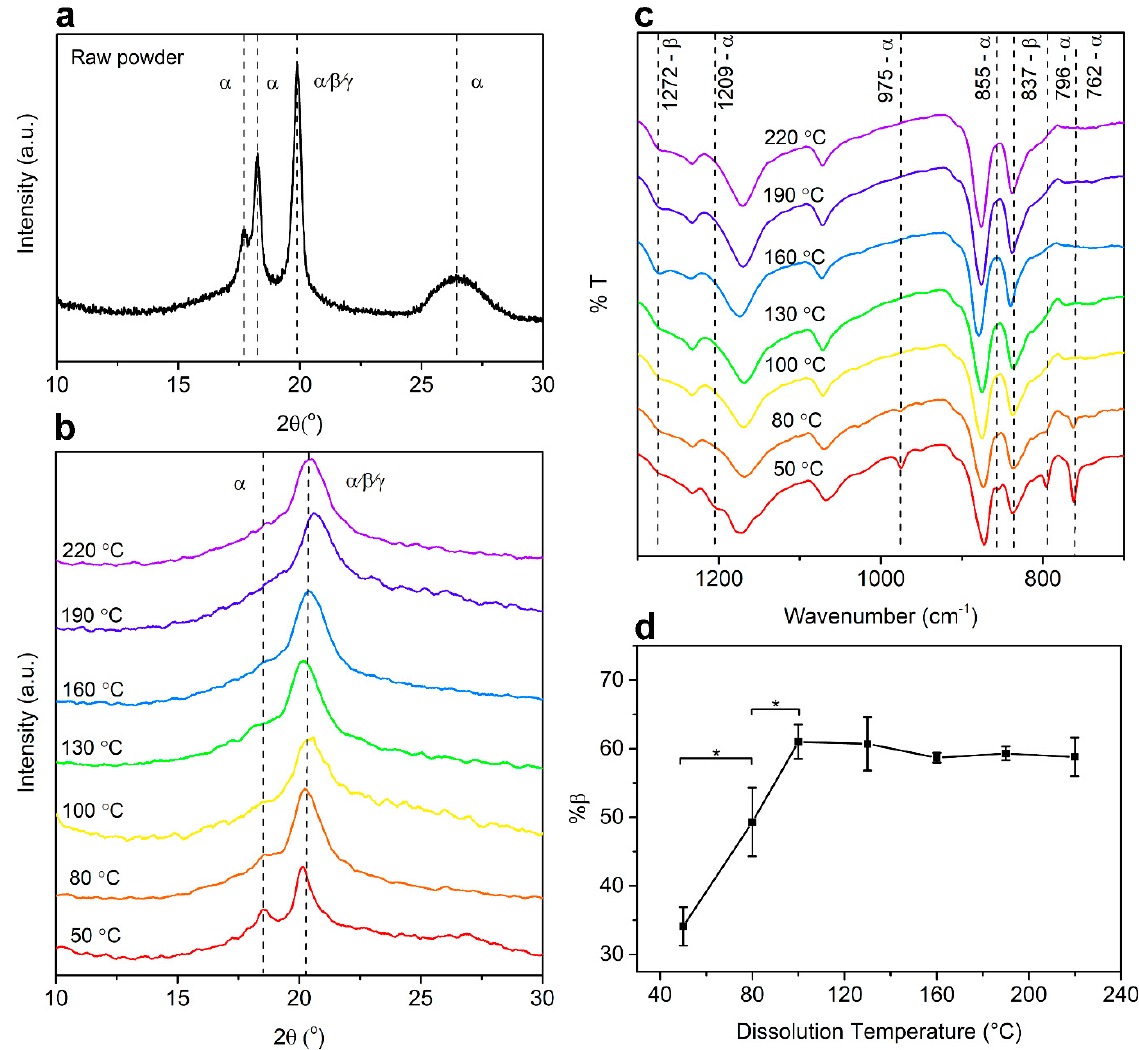
Figure 1. Phase characterization of polyvinylidene fluoride (PVDF). ( a ) X-ray diffraction (XRD) spectra indicating the characteristic peaks of α -PVDF and β -PVDF for raw PVDF powder. ( b ) XRD spectra and ( c ) Fourier-transform infrared spectroscopy (FTIR) spectra of PVDF films fabricated at dissolution temperatures of 50 to 200 °C. ( d ) Comparison of β -PVDF content at increasing dissolution temperatures (* p < 0.05, n = 3).